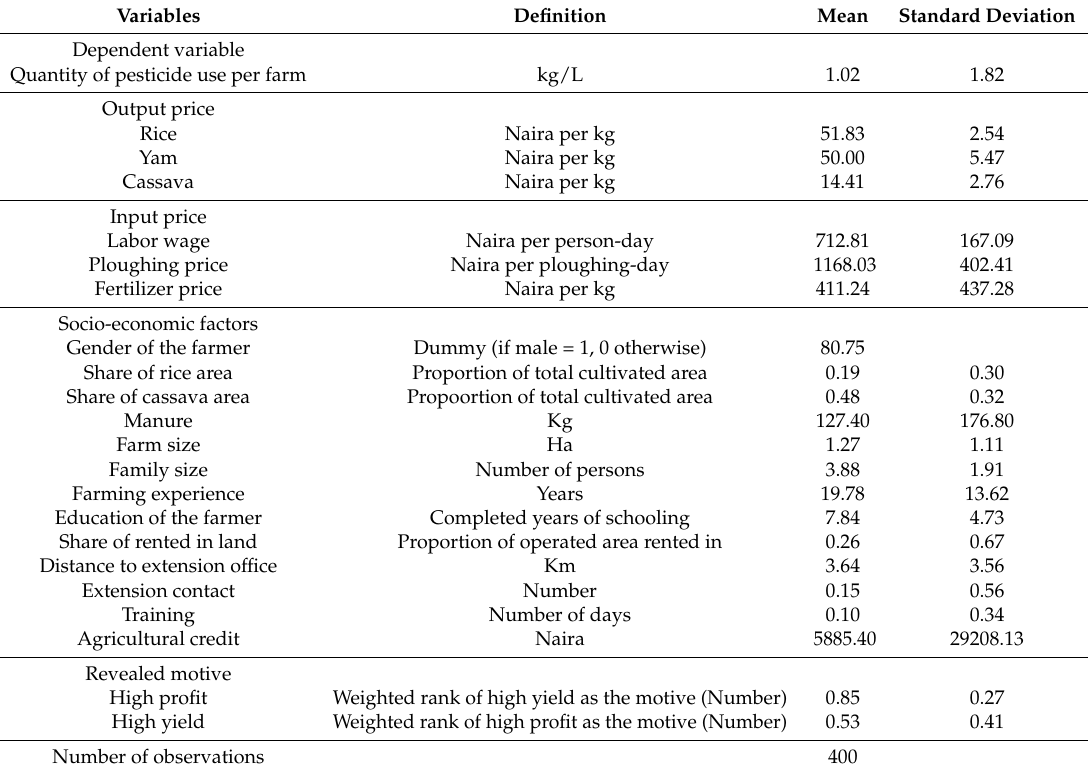
Table 1. Definition, measurement, and summary statistics of the